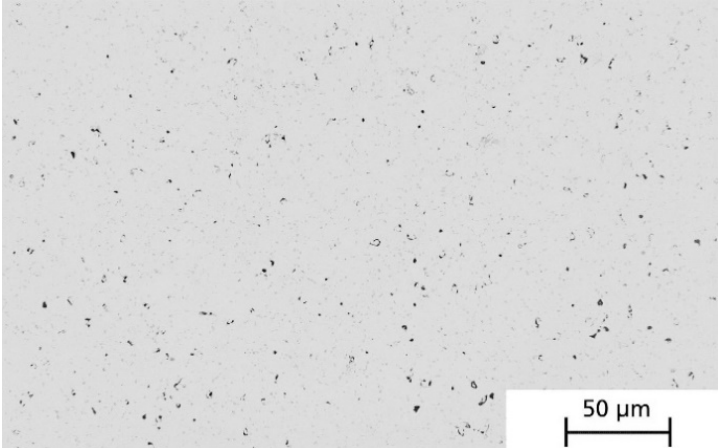
Figure 7. Micrograph of a sintered specimen within the printing strand with a residual porosity of 1.0 ± 0.7%.